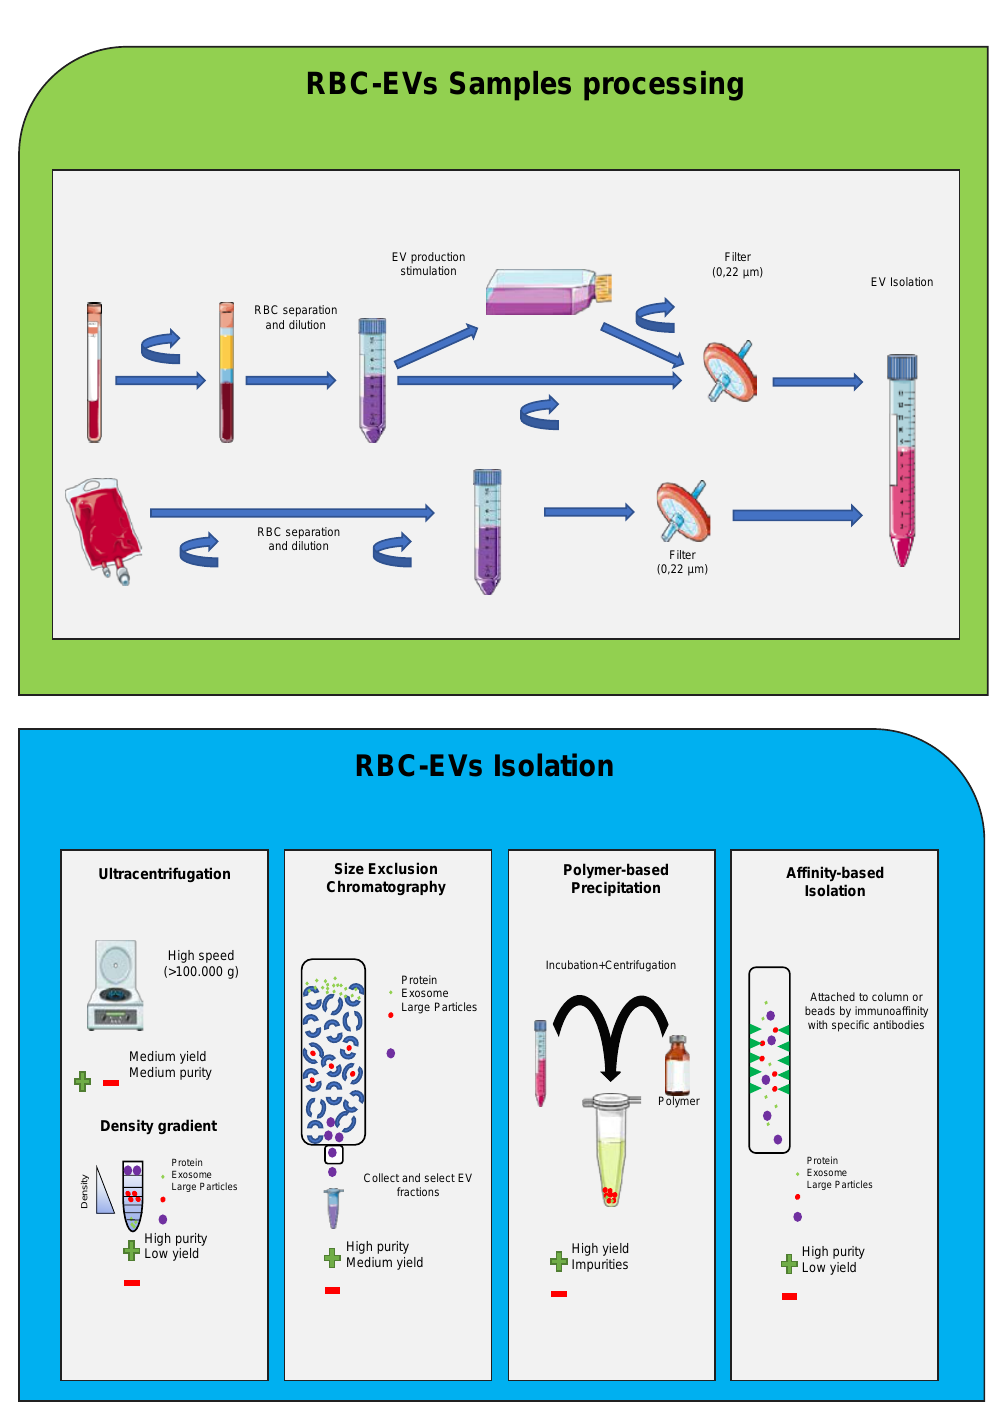
Figure 3. Schema illustrating several methods used to isolate extracellular vesicles (EVs) from red blood cells (RBCs). These methods include ultracentrifugation, size exclusion chromatography, precipitation, and affinity-based isolation.